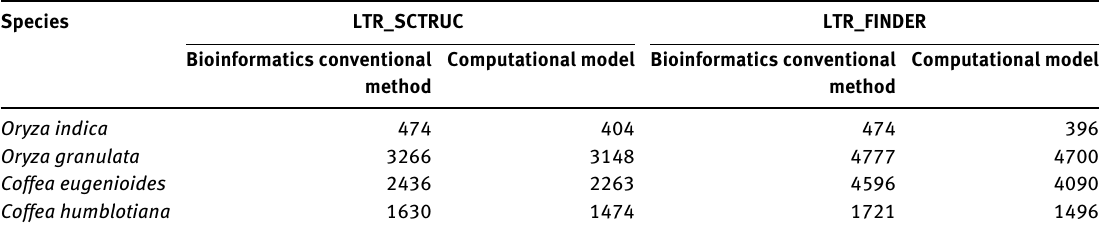
Table 6: Number of sequences obtained by executing each of the methods for LTR_STRUC and LTR_FINDER data sets. Species